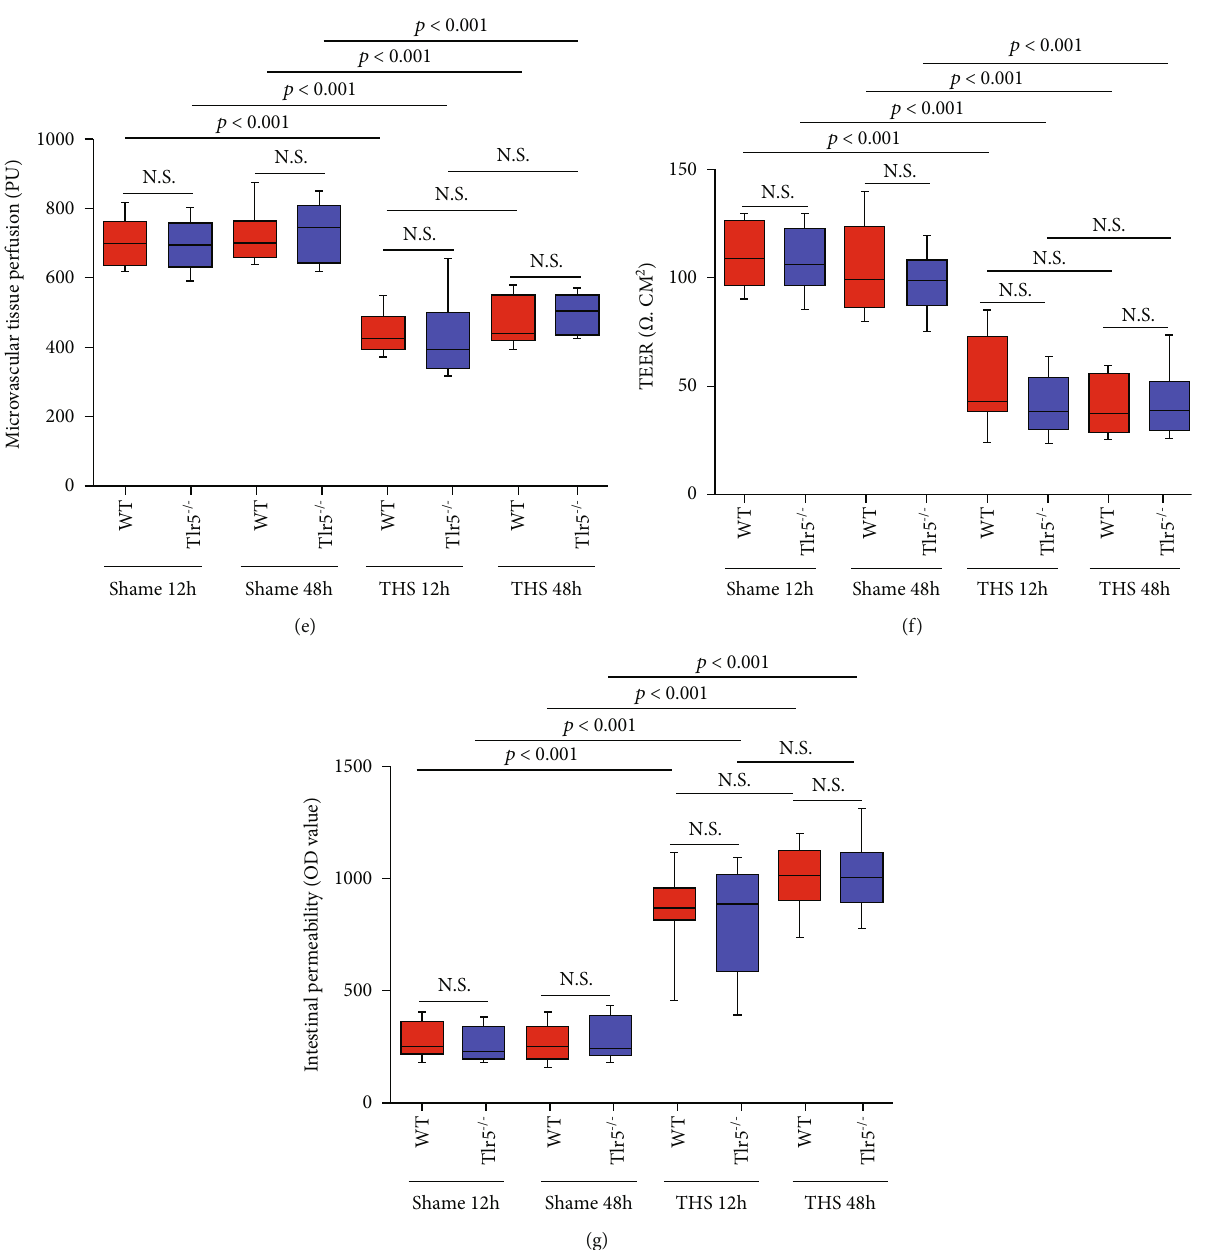
Figure 3: Pro fi le of intestinal mechanical barrier after THS. MAP refers to the mean arterial pressure of the mouse and was monitored during THS and fl uid resuscitation (a) and compared with the value obtained at the end of fl uid resuscitation (b). Microvascular tissue perfusion was monitored during THS and fl uid resuscitation (c) and compared with the value at the end of fl uid resuscitation (d) and compared with the values at 12 and 48 hours after THS (e). Ex vivo transepithelial electrical resistance (TEER) (f) and in vivo permeability (g) of the small intestine were measured and compared. Data are expressed as the mean ± SD and represent three independent experiments involving 8 animals per group. All signi fi cant p values are marked, and p < 0 : 05 is considered signi fi cant by the repeated measures ANOVA test for MAP and microvascular tissue perfusion and by the one-way ANOVA test for other